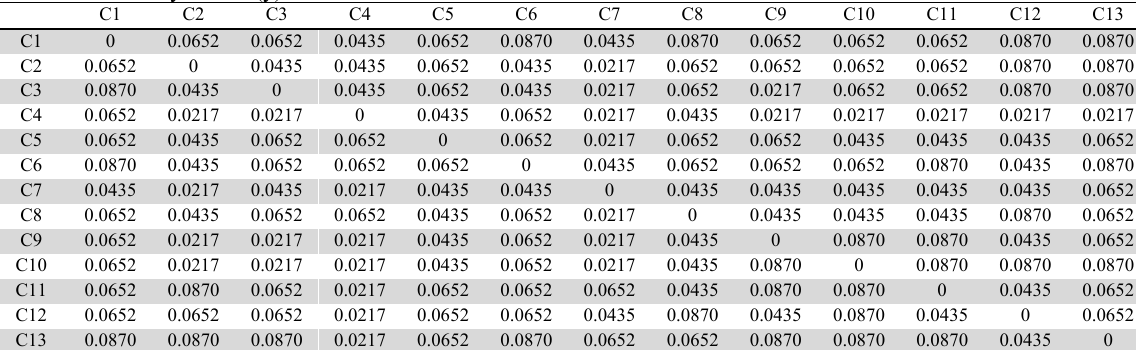
Total-relation fuzzy matrix (y).